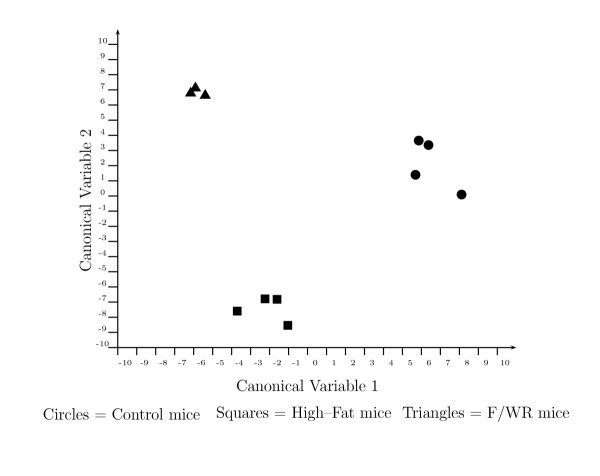
Fisher discriminant analysis plot of mouse liver samples. Samples were scored according to the canonical variables determined by Fisher Discriminant Analysis (FDA). Each canonical variable is defined as a weighted sum of 100 specific genes, including each of the 41 genes contained in Table 3 (See Additional file: 1). To score a sample, the gene expression value is multiplied by an FDA coefficient, called a loading, and the products from the 100 genes used in the analysis are summed to give the canonical variable score for the sample. F/ WR: Fasting/ Weight Reduced.